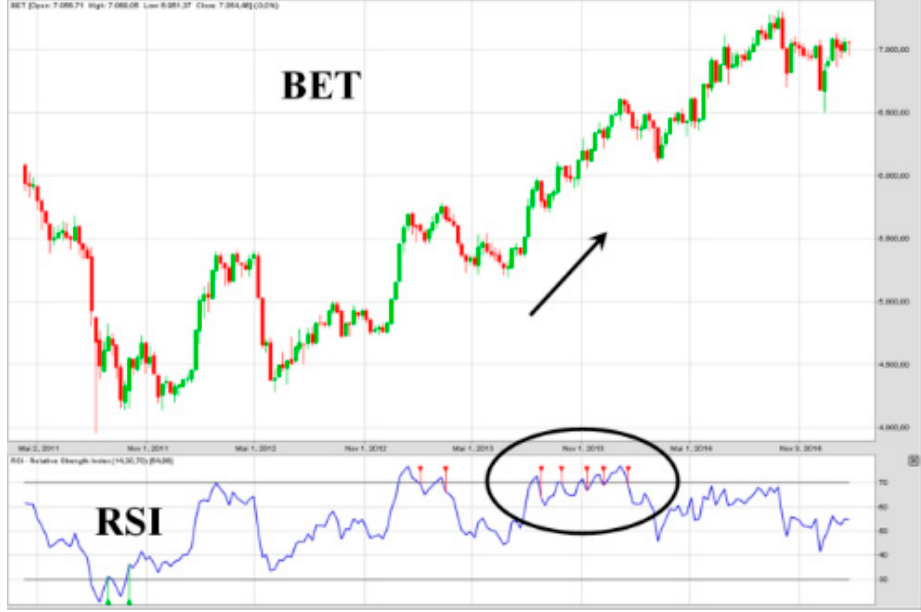
Figure 3. The precision of technical oscillators. Source: Authors’ processing is based on data available on https://www.ifbfinwest.ro/complexcharts/index.php?id_lista=1786 (accessed on: 12.09.2014).